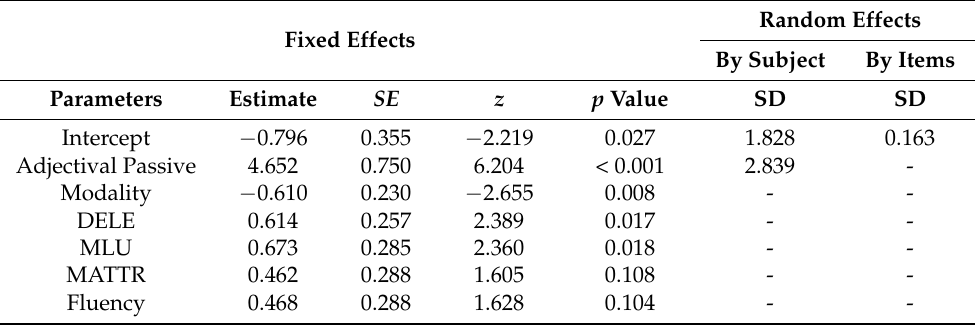
Table 11. Parameter estimates for HL learners’ comprehension of passive clauses by